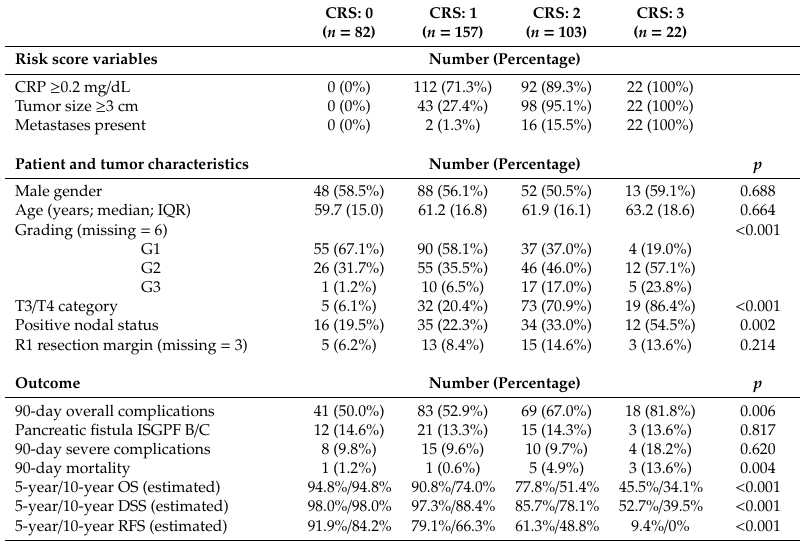
Table 3. Patient characteristics, postoperative histopathological details, and outcomes according to pancreatic neuroendocrine neoplasm (panNEN) clinical risk score groups (combined cohort; n = 364). CRS: 0 ( n =